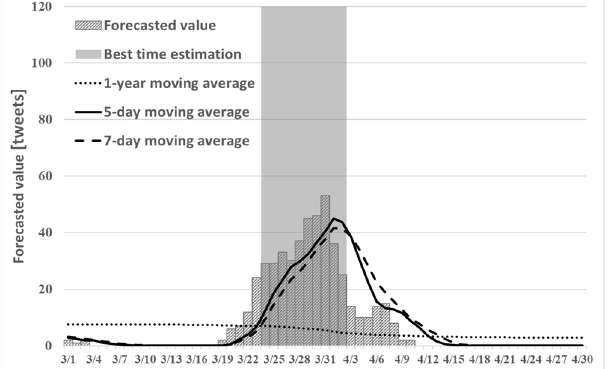
Figure 6. Kyoto after forecasting in 2019 (proposed method (1)).